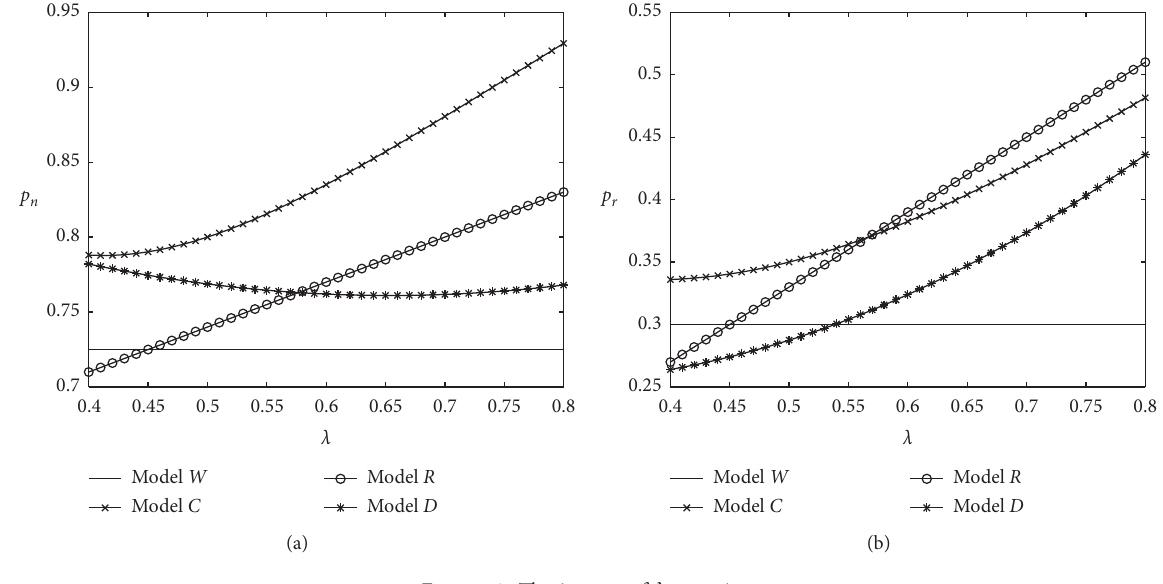
Figure 3: The impact of λ on price.